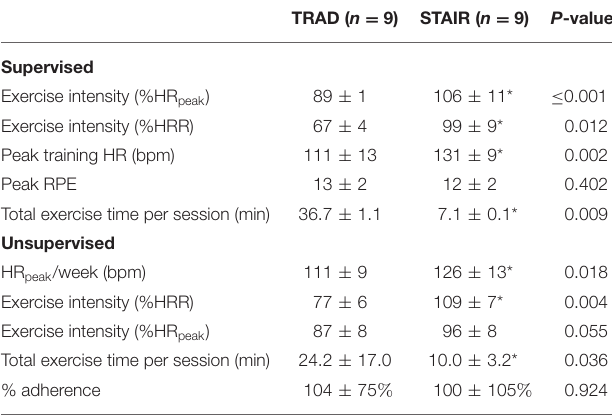
TABLE 2 | Average responses during supervised and unsupervised exercise training